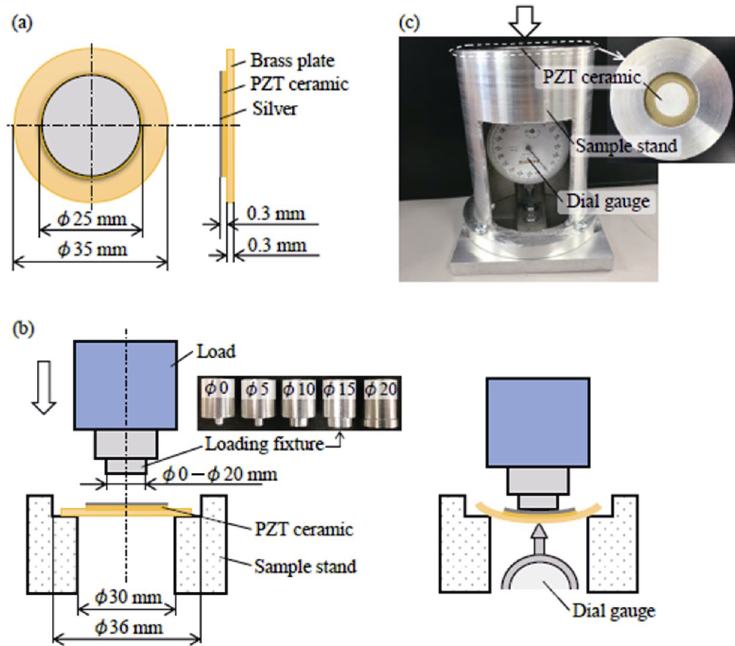
Fig. 1 Schematic diagrams of (a) PZT ceramic plate, (b) loading apparatus for investigating electric-power generation by PZT ceramic plate, and (c) apparatus to measure